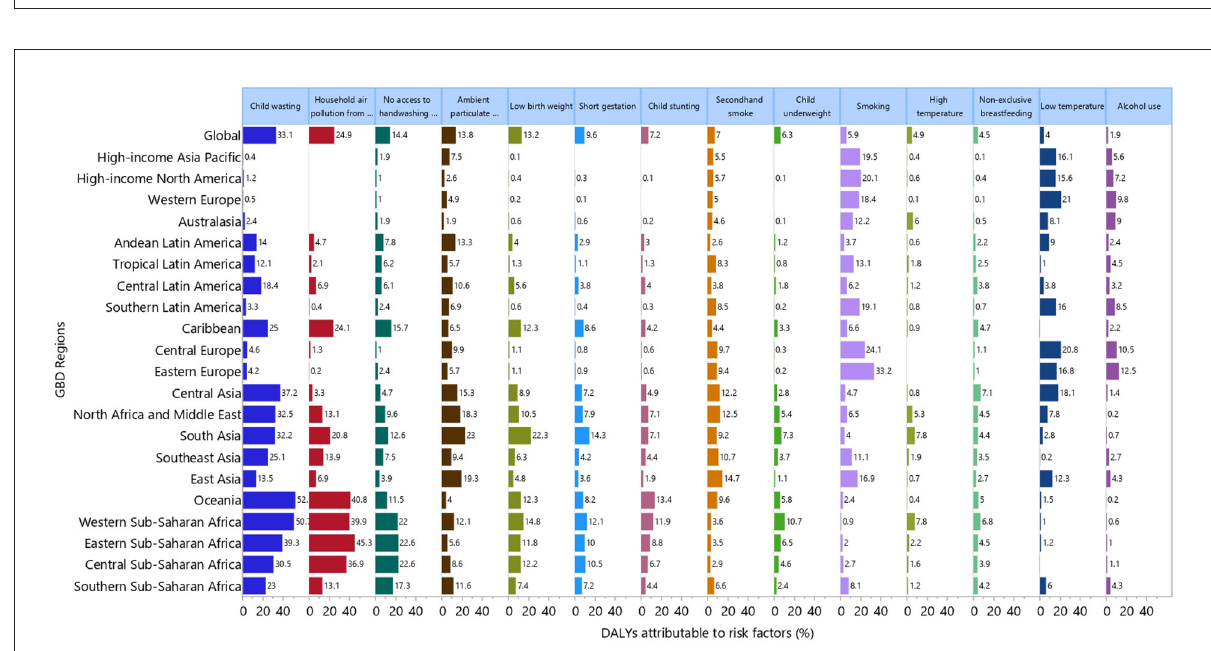
peaked in the < 1-year age groups and then decreased with age up to the 15–19 age group before again increasing up to the 80–84 age group. Similarly, the number of DALYs